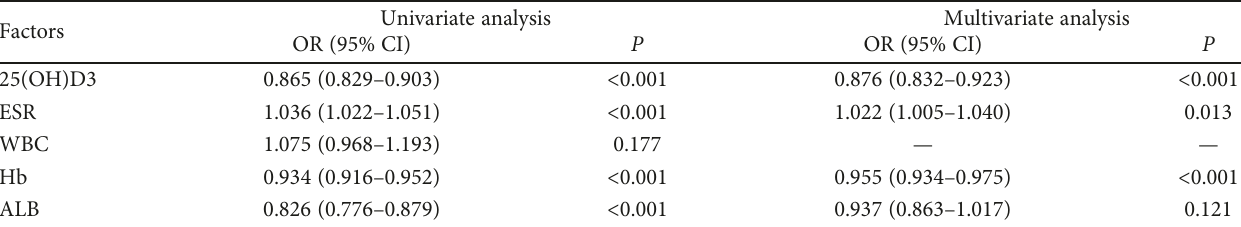
Table 5: Logistic Regression for disease activity.